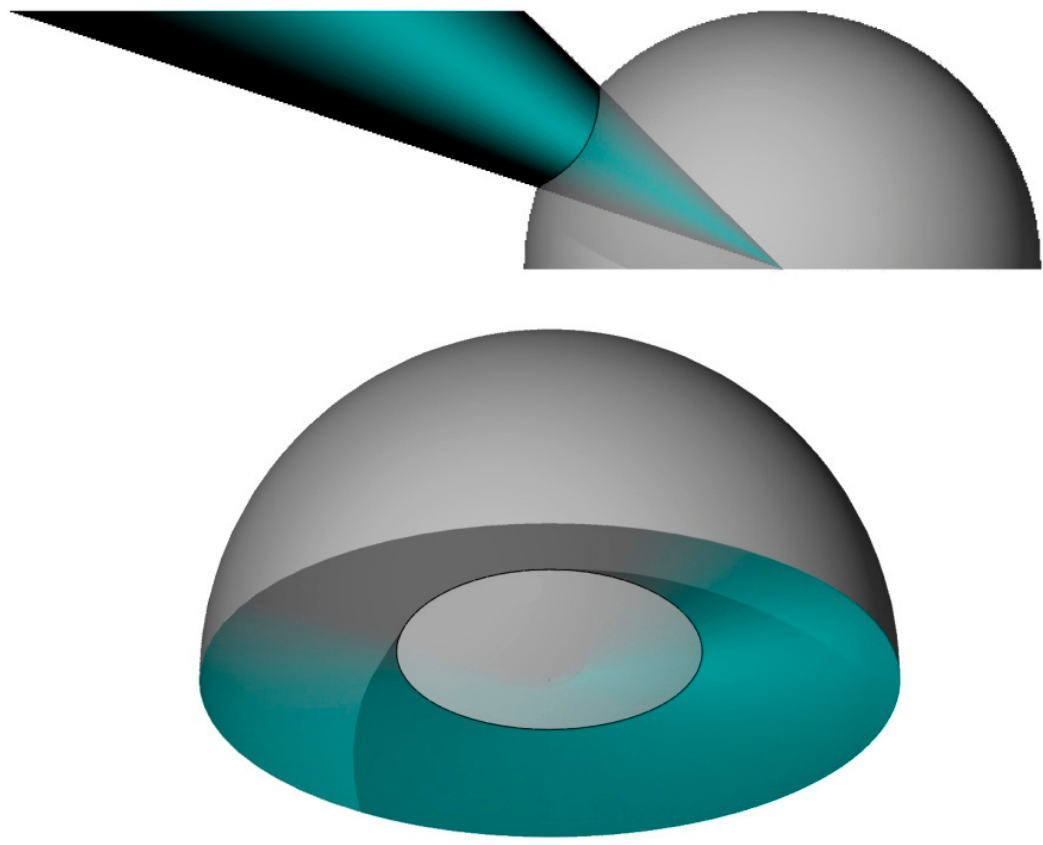
Figure A10. ( Top ). Projection of the intersection parallel to the axis of the cone: Hyperbola. ( Bottom ). Projection of the intersection normal to the axis of the cone: Ellipse.